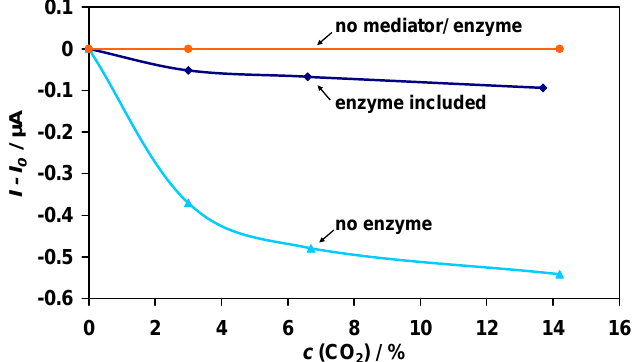
Figure 8. Cross-sensitivity of the enzymatic biosensor to CO Successively, the biological components enzyme, NAD + , and the mediator PT were